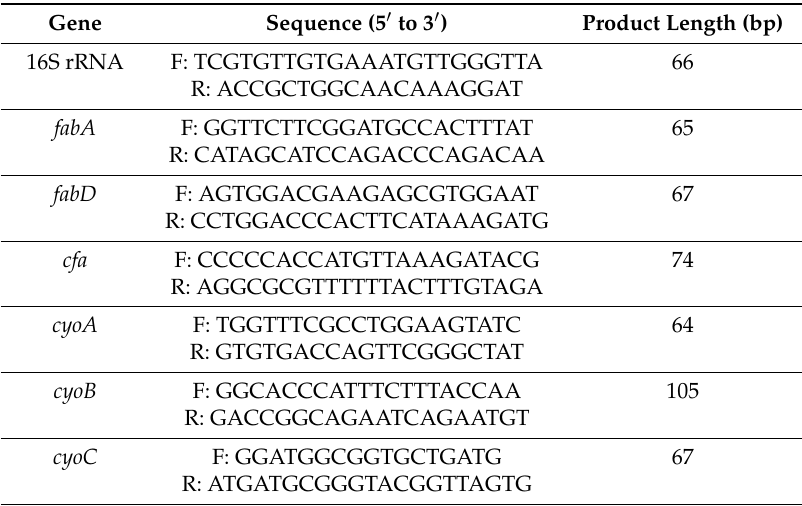
Table 2. Primers of fatty acid biosynthesis-associated genes and cytochrome bo oxidase genes used in this